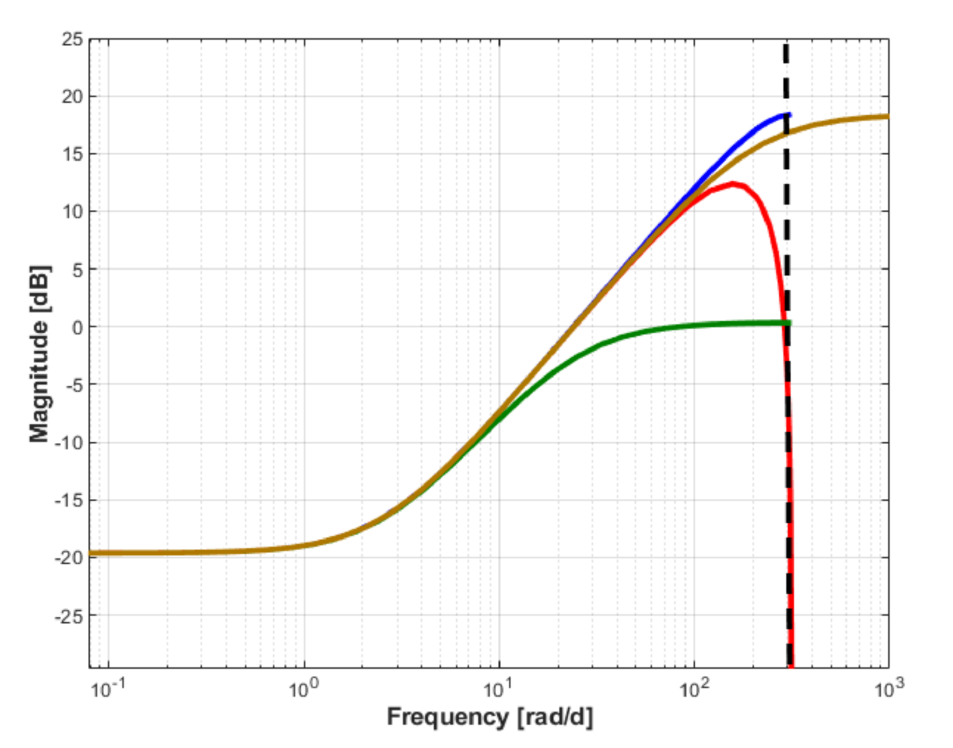
Figure 10. The Bode plot for: Q ( z, θ ) identified (red), low order analog (brown), low order digital (blue) and limited frequency digital (green).